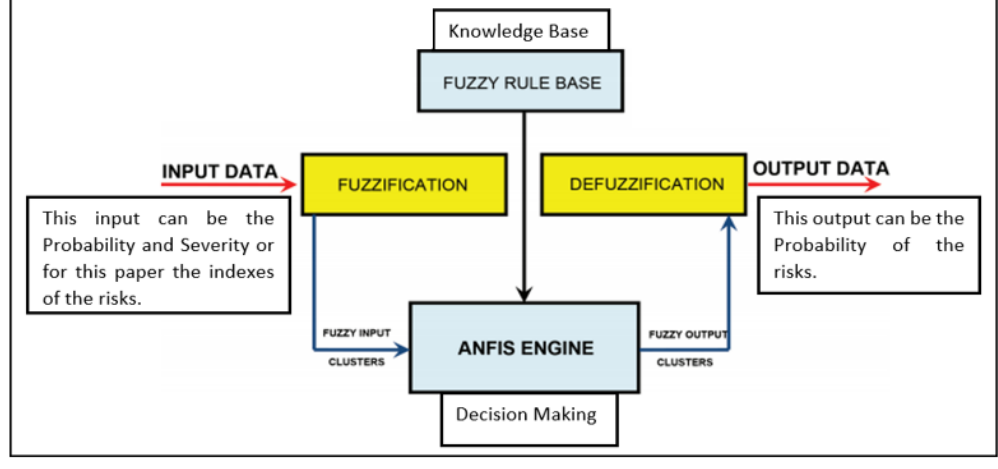
Figure 2. Proposed Fuzzy logic inference system for risk management in railway stations.